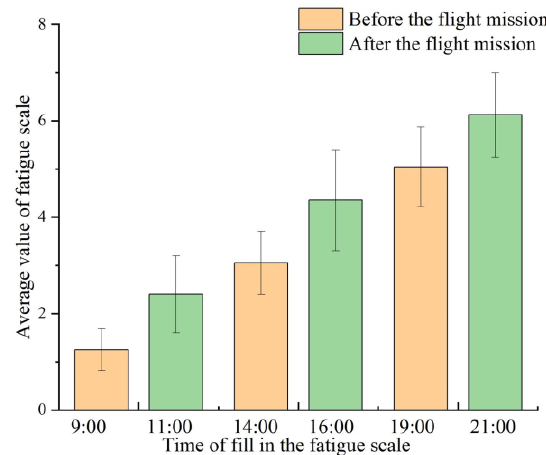
Figure 9. The statistics of Samn – Perelli 7-Level fatigue scale.